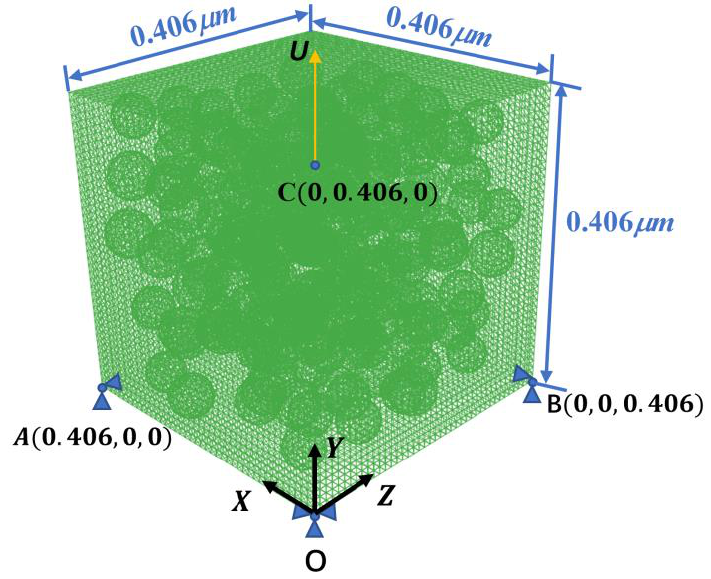
Figure 6. The 3D RVE model of silicone elastomer filled with EC − 300J CNPs with 30% volume fraction.